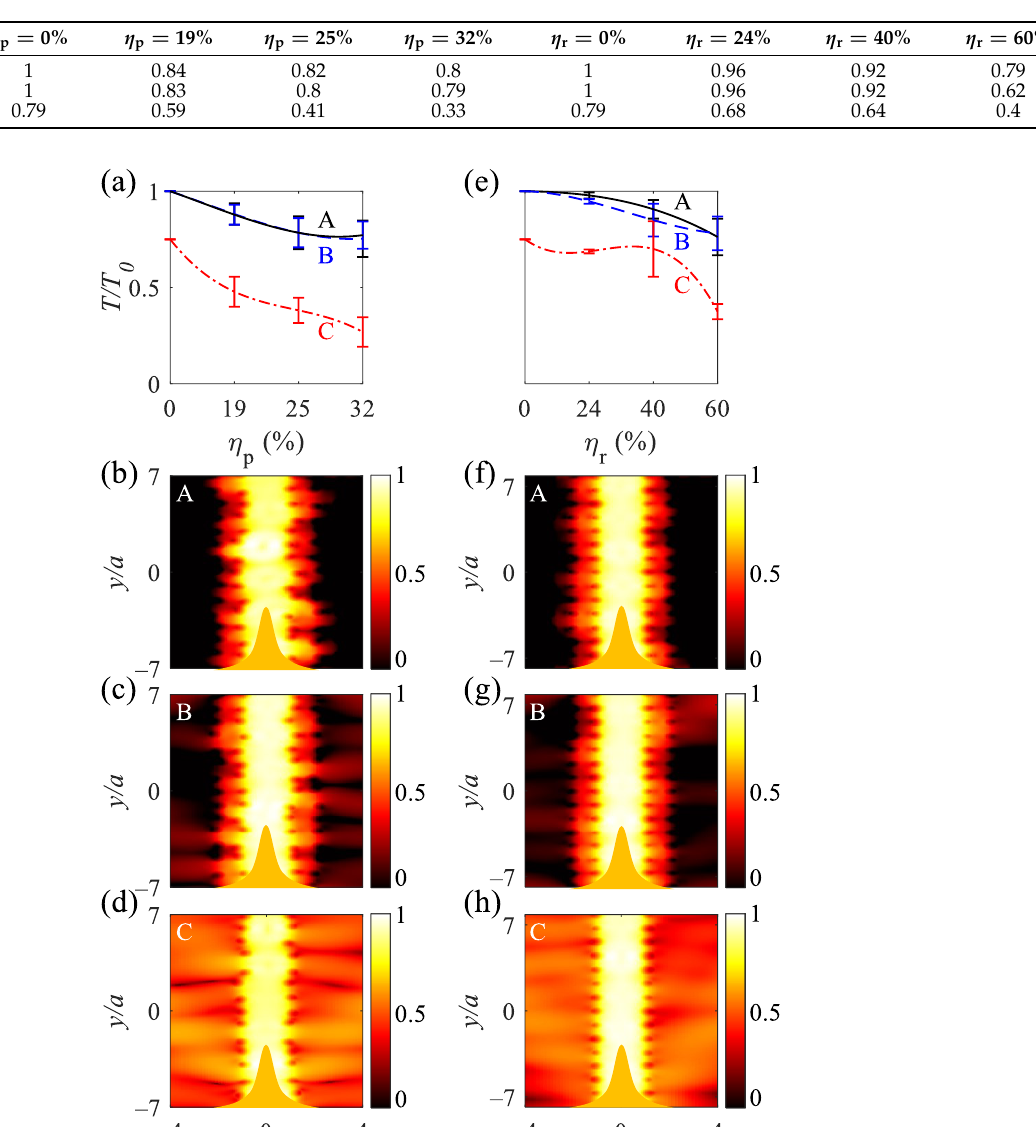
Table 3. The average normalized transmission for the L-shaped waveguide under radius and position disorderings.